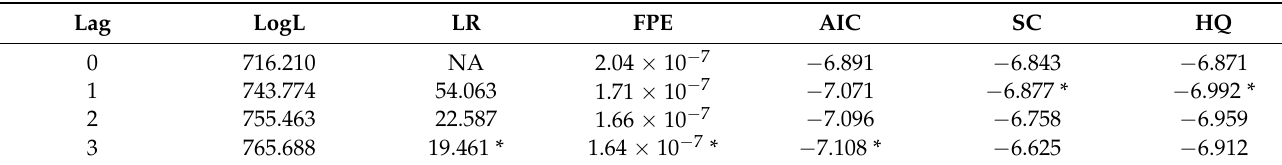
Table A3. Lag order